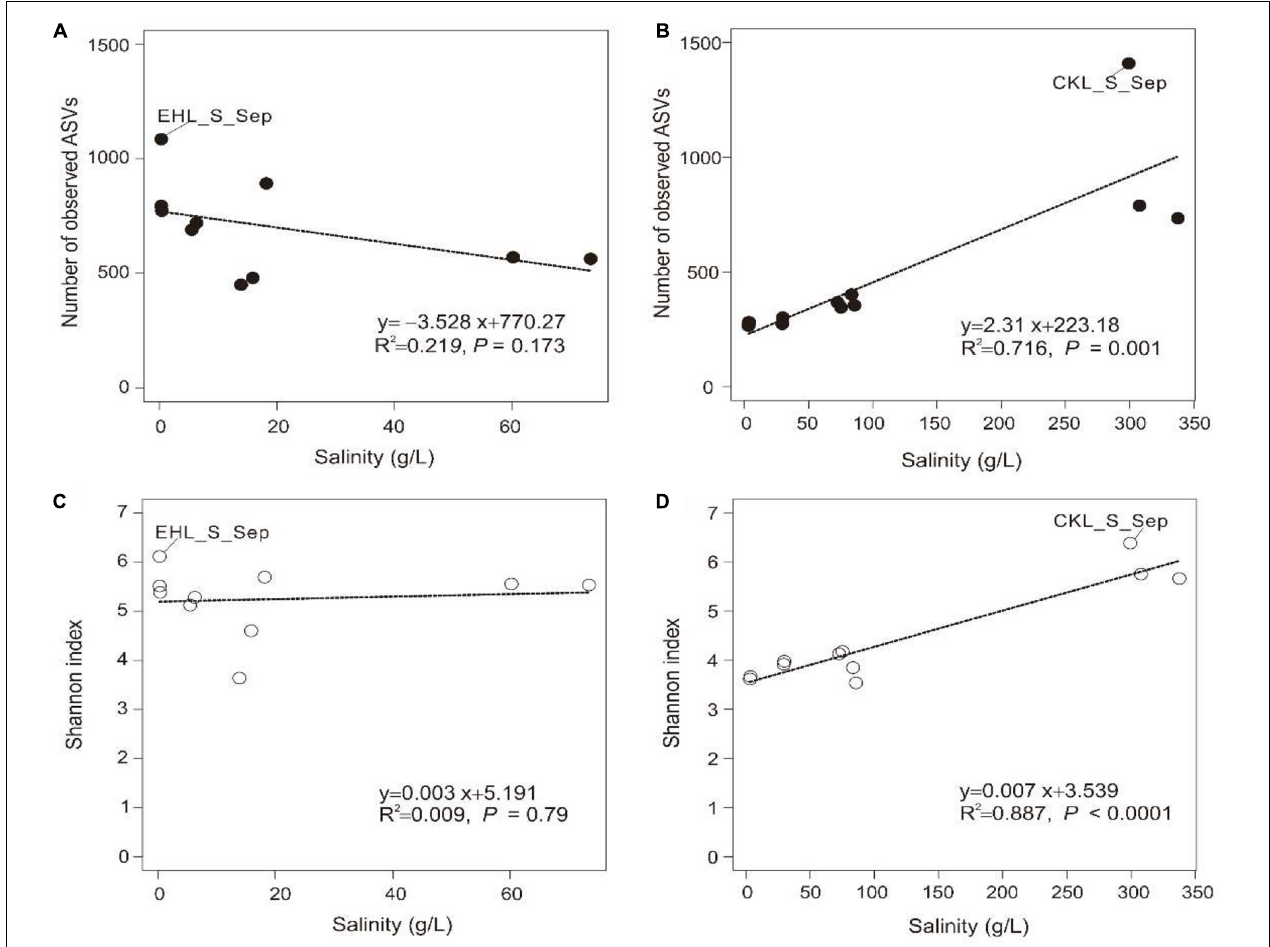
FIGURE 3 | Relationship between salinity and alpha diversity (observed ASVs, Shannon diversity). (A,C) Relationship between salinity and observed ASVs, Shannon index in experiment 1 (simulating salinization), respectively. (B,D) Relationship between salinity and observed ASVs, Shannon index in experiment 2 (simulating desalinization), respectively. Linear regression is shown in the bottom right